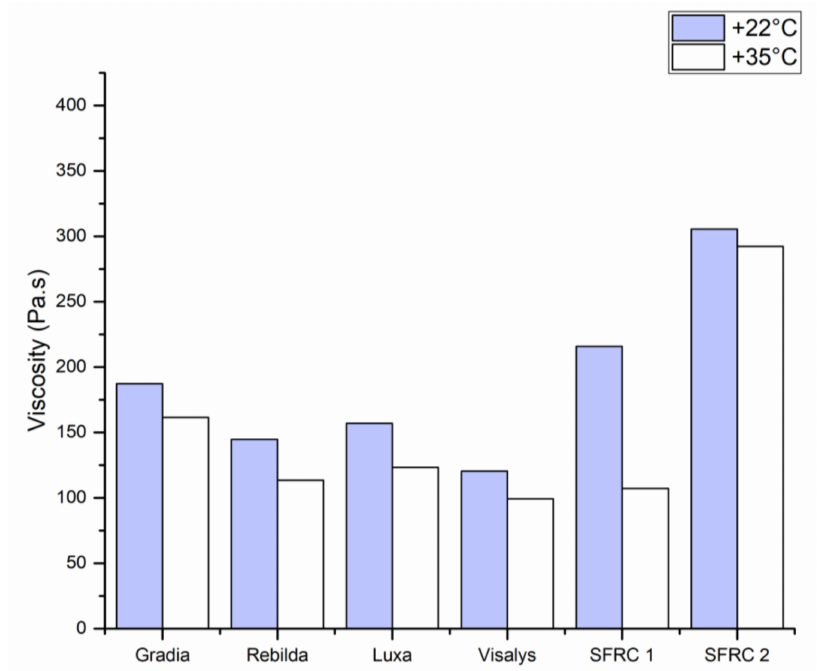
Figure 4. Bar graph illustrating the means of viscosity (Pa · s) of tested DC resin composites using rotational rheometer at 15 s after mixing with different temperatures.